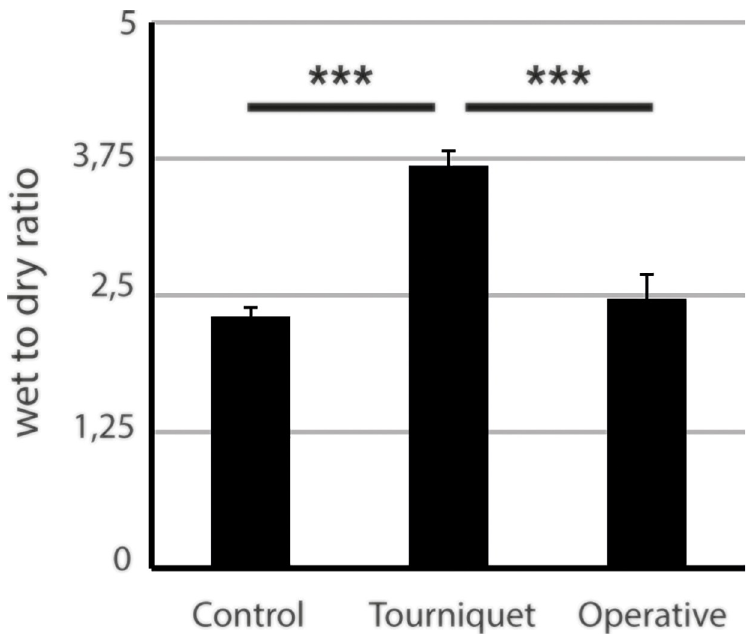
Fig 4. Measurement of wet to dry ratio in the low-pressure tourniquet group and operative clamping cohort. After 2 hours of ischemia and 4 hours of reperfusion the low-pressure tourniquet group showed a significant increase in edema compared to both sham and operative clamping. Results are shown as means ± SEM. P-value: ��� < 0.001; (ANOVA), n = 4.